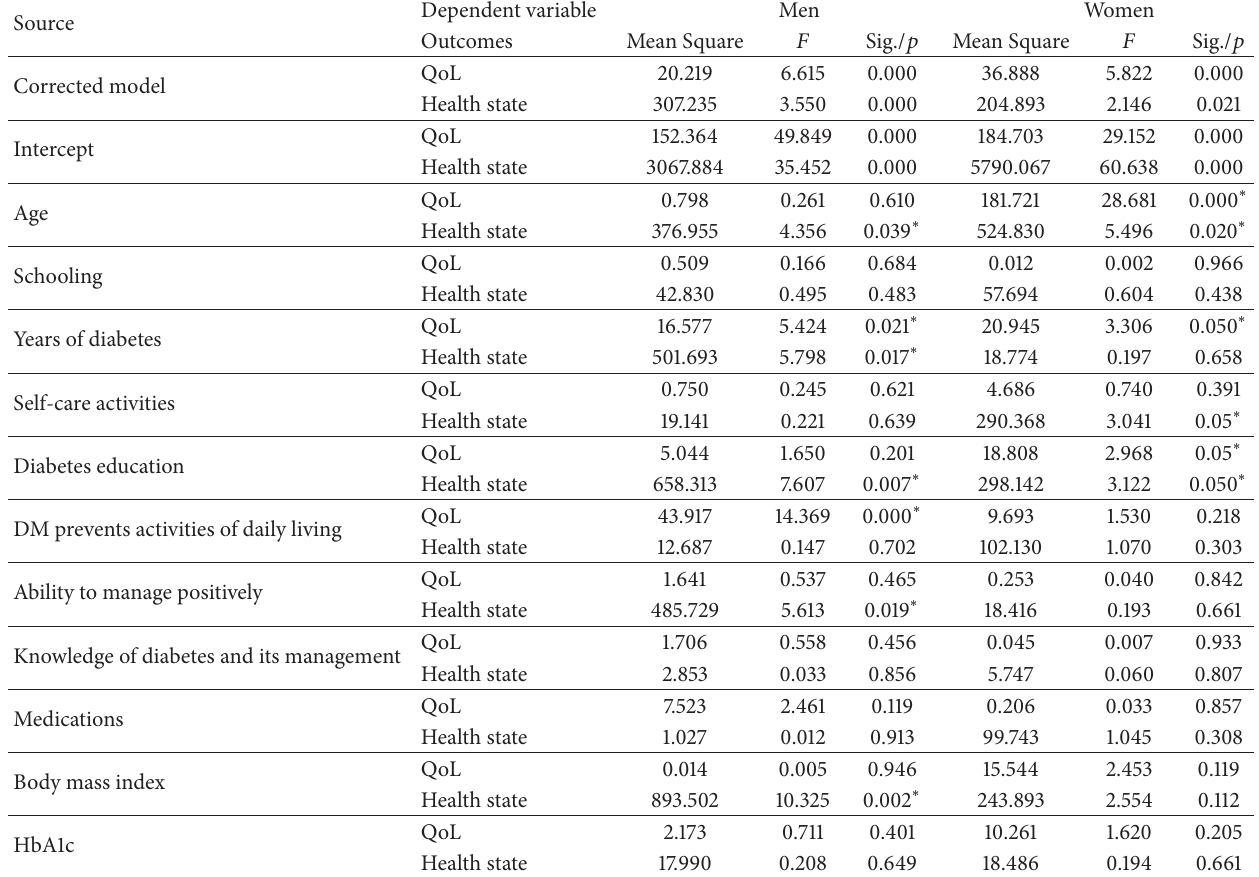
Table 5: Overall model significance and tests of between-subjects